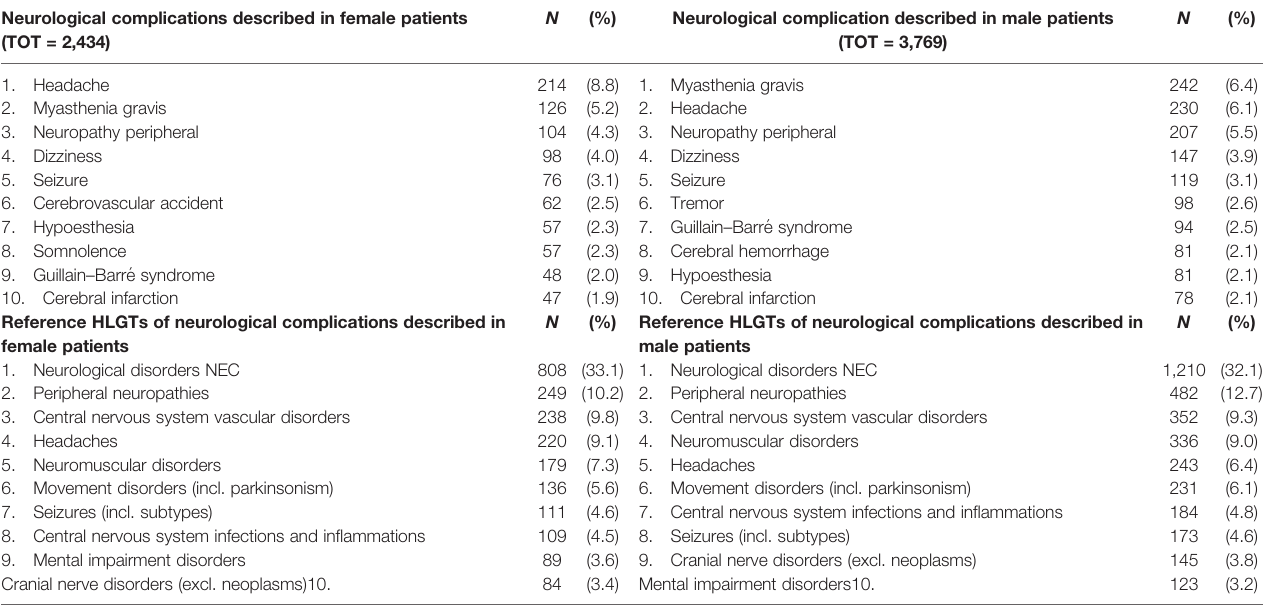
TABLE 3 | Top 10 neurological complications and HLGTs more frequently described and collected in the EudraVigilance, categorized by gender. Neurological complications described in female patients (TOT = 2,434)